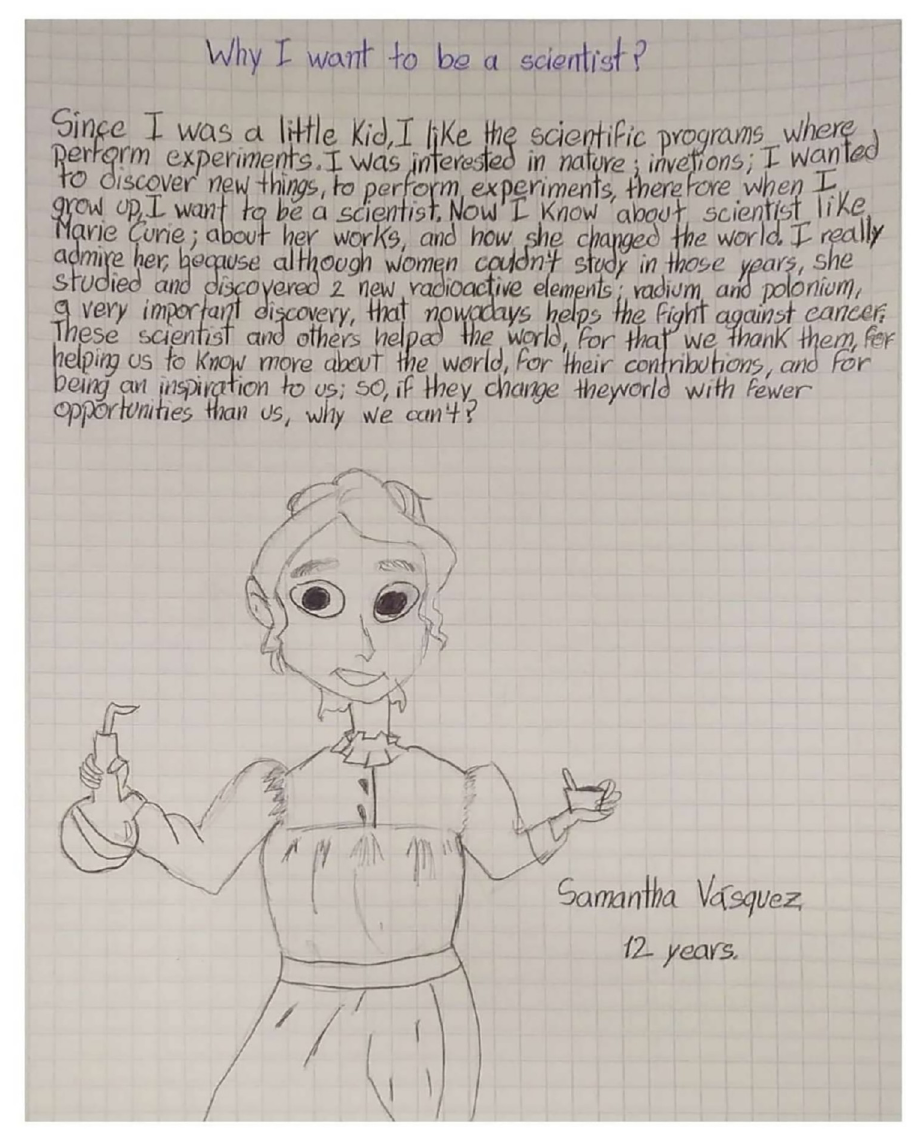
Fig 2. Letters of girls interested in science (Written by Samantha Va ´